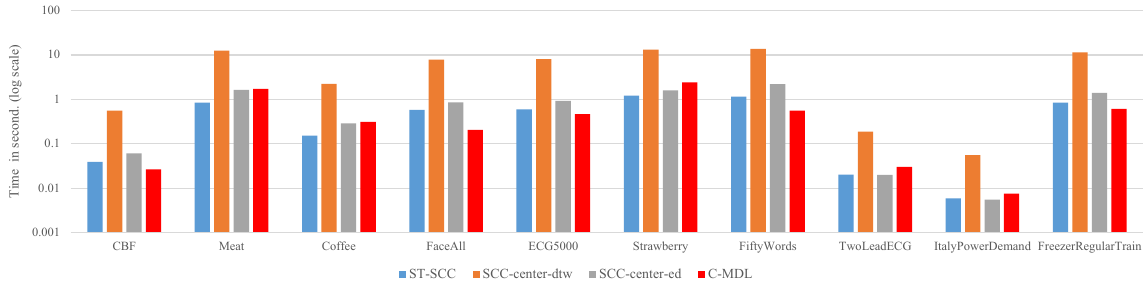
Figure 8. The efficiency of each method on different datasets. The ST-SCC , SCC-center-ed and C-MDL have similar performance. However, SCC-center-dtw is significantly more time-consuming than